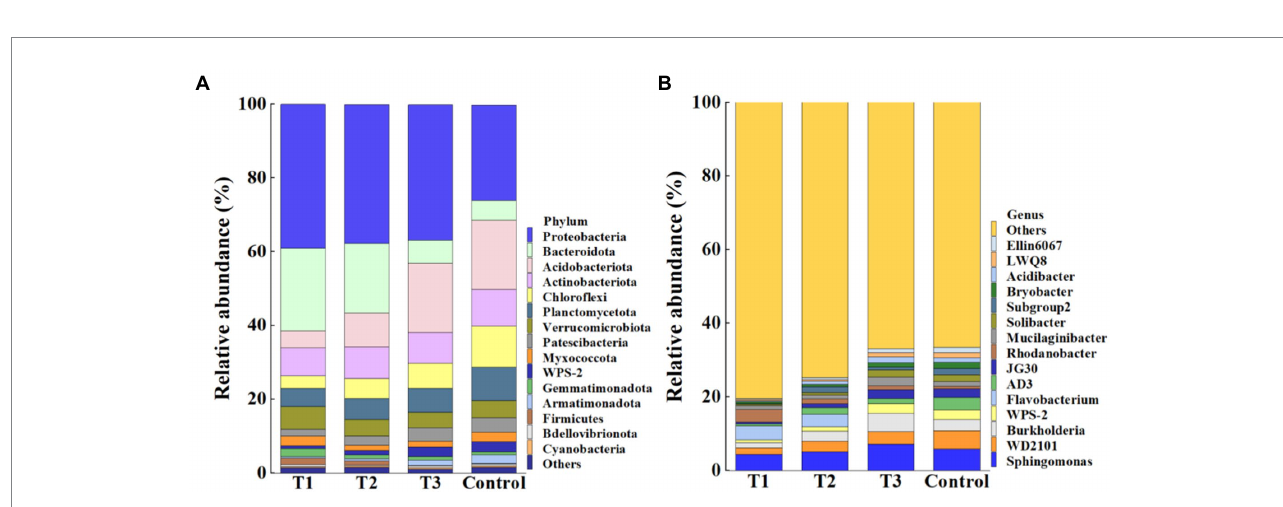
FIGURE 4 Relative abundance of bacteria at the phylum (A) and genus (B) level. T1: MF-HZ23 at 3.00 kg/m 2 ; T2: MF-HZ23 at 3.00 kg/m 2 plus CCF at 0.02 kg/m 2 ; T3: CCF at 0.04 kg/m 2 ; and T4: